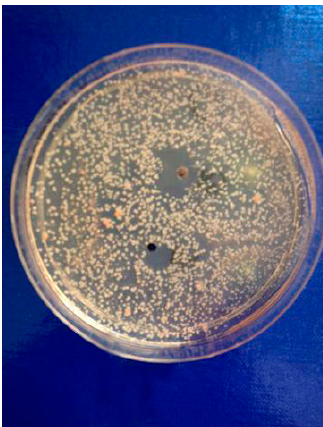
Figure 1. The results of susceptibility assessment of Rhodotorula rubra to the mixture of C-2 ester guaianolides (compound 1 inhibition zone diameter = 12, compounds 2 – 4 inhibition zone diameter = 22 mm).